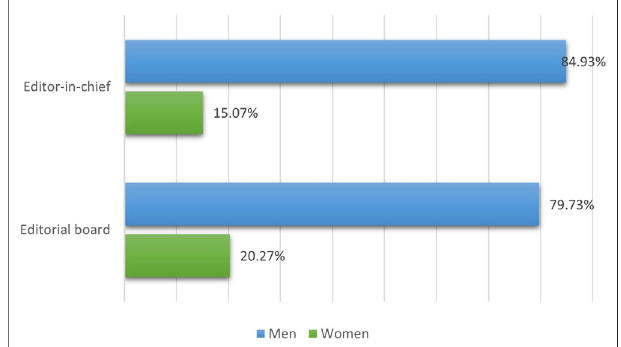
FIGURE 1 | Gender representation in the position of editor(s)-in-chief and gender representation of the editorial board among the 53 journals classi fi ed within the category of “ Geology ” in